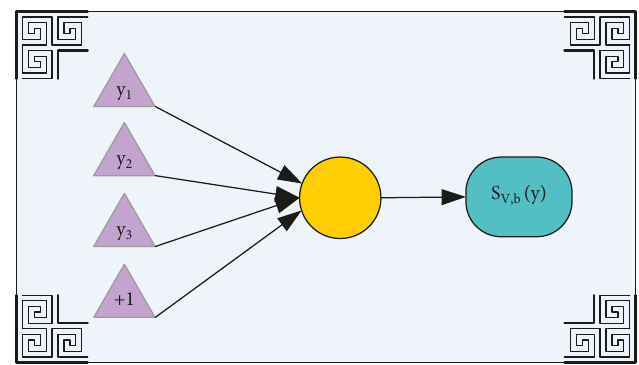
Figure 3: Schematic figure of neuron structure.